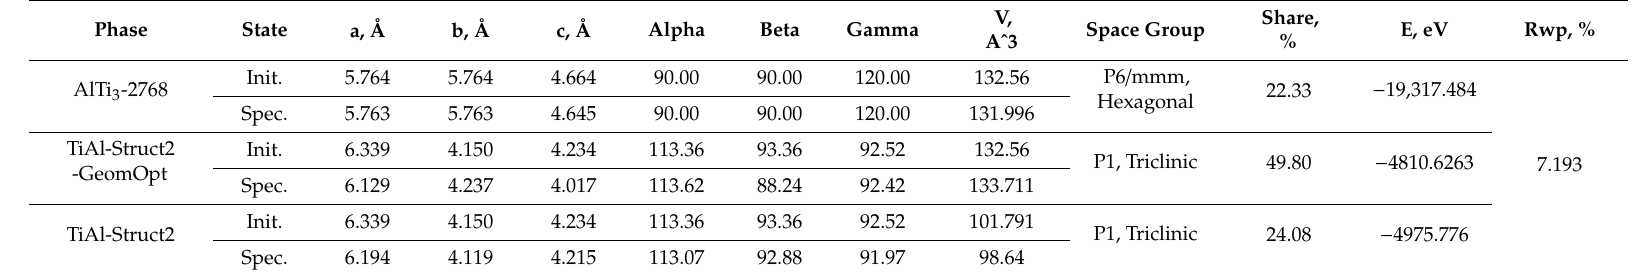
Table 1. Structural parameters of the lattices and the share of phases, and the convergence criterion of the TA alloy.